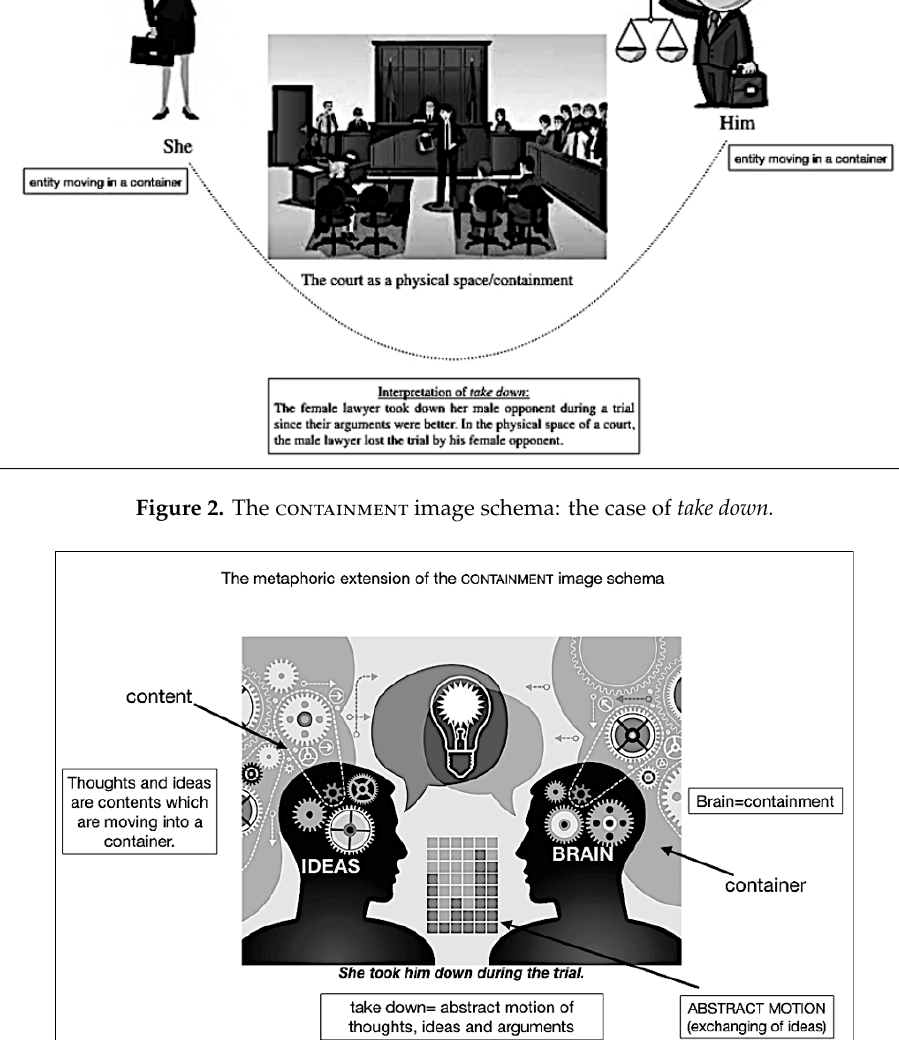
Figure 3. The metaphorical extension of the CONTAINMENT image schema: the case of take down.